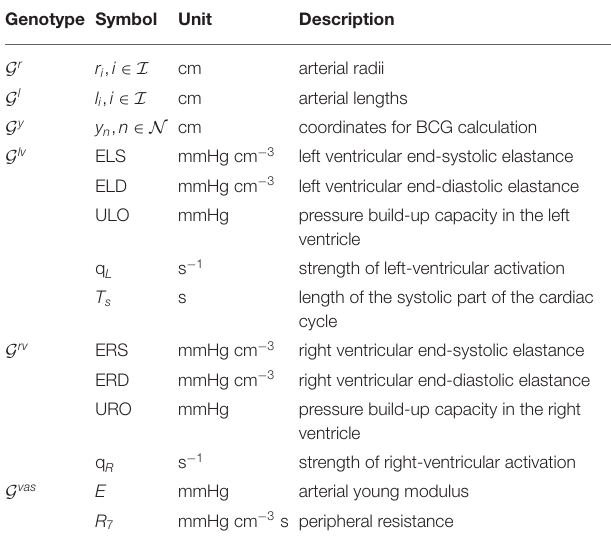
TABLE 2 | Summary of the model parameters in the genotypes considered in the evolutionary algorithm (EA). Genotype Symbol